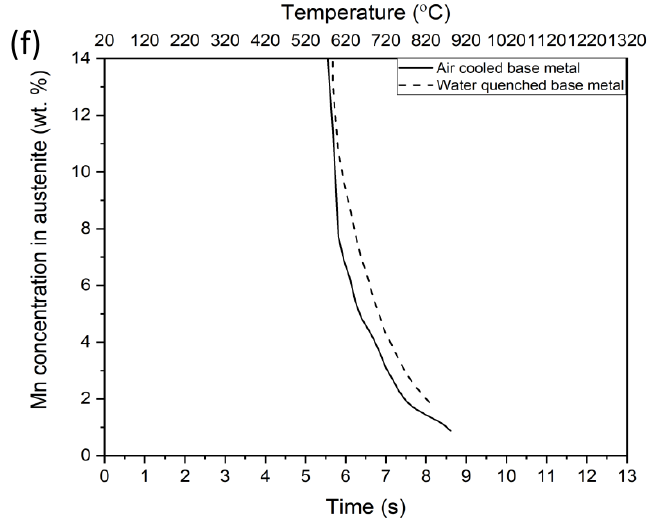
Figure 11. DICTRA and PRISMA calculations to understand the kinetics of austenite formation during CGHAZ simulation with different starting microstructures. ( a ) Evolution of phases as a function of time for the air-cooled and water-quenched starting microstructure, ( b ) normalized driving force for austenite formation as a function of temperature, ( c ) C concentration in ferrite as a function of transformation time, ( d ) Mn concentration in ferrite as a function of transformation time, ( e ) C concentration in austenite as a function of transformation time, and ( f ) Mn concentration in austenite as a function of transformation time.